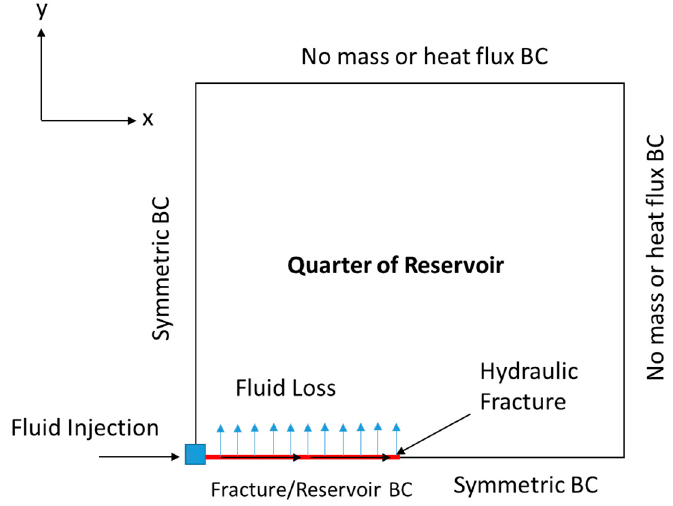
Figure 3. Schematic (top view) showing one quarter of the reservoir domain, including the location of the wellbore and hydraulic fracture.